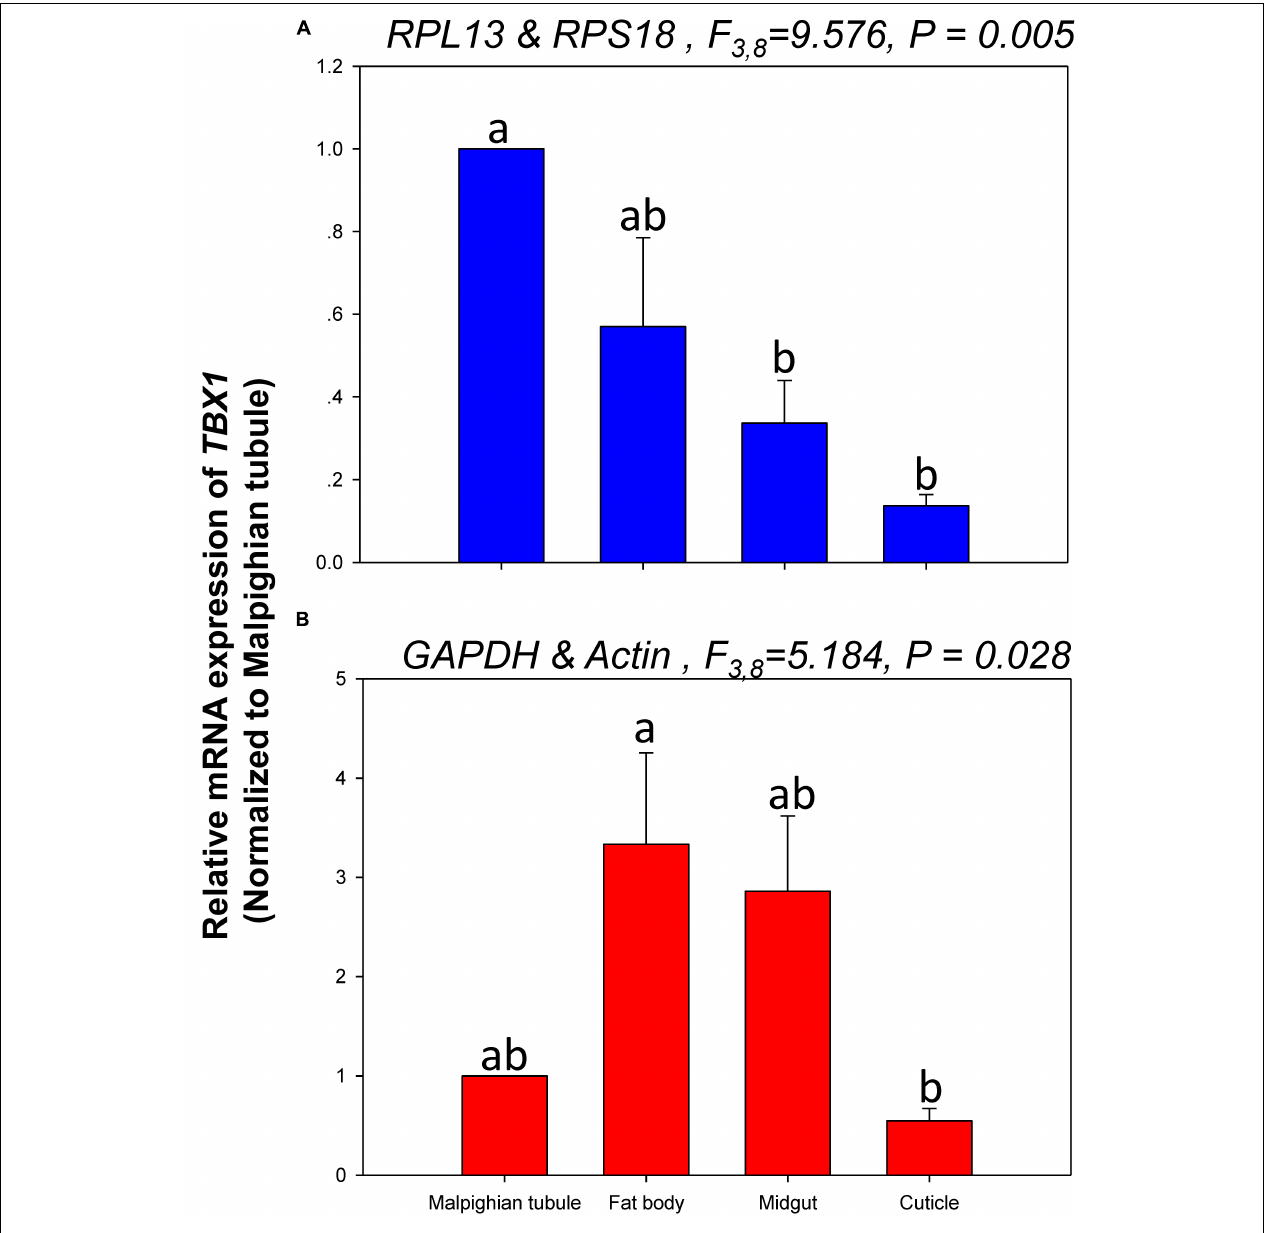
FIGURE 6 | Relative gene expression of TBX1 in different tissues of H. vigintioctomaculata . The relative gene expression levels of TBX1 in the Malpighian tubule, fat body, midgut, and cuticle were normalized to the best stable ( A , RPL13 and RPS18 ) and least stable ( B , GAPDH and Actin ) reference genes, respectively. The values are means + SE. Different letters indicate significant differences in gene expression among different tissues of H. vigintioctomaculata ( P <